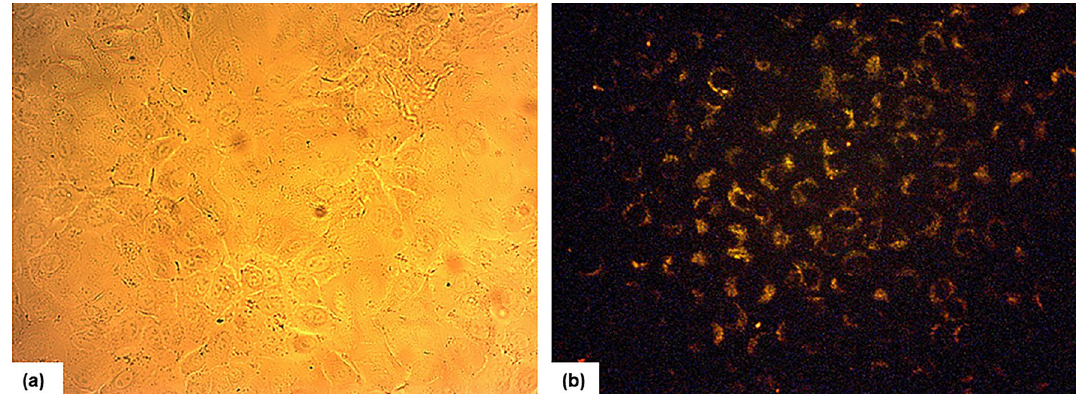
Figure 8. Fluorescence imaging of PLA-PEG-Apt/DOX NPs in A-549 cells. ( a ) Bright field, and ( b ) Dark field for A-549